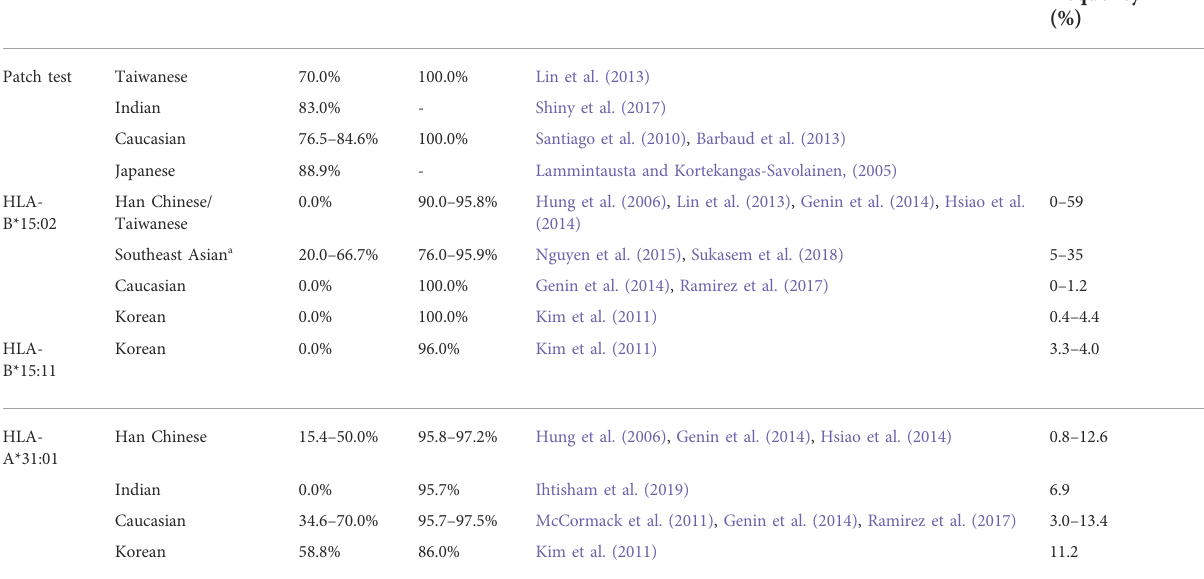
TABLE 3 Sensitivity and speci fi city of patch tests and HLA tests for carbamazepine-induced MPE.